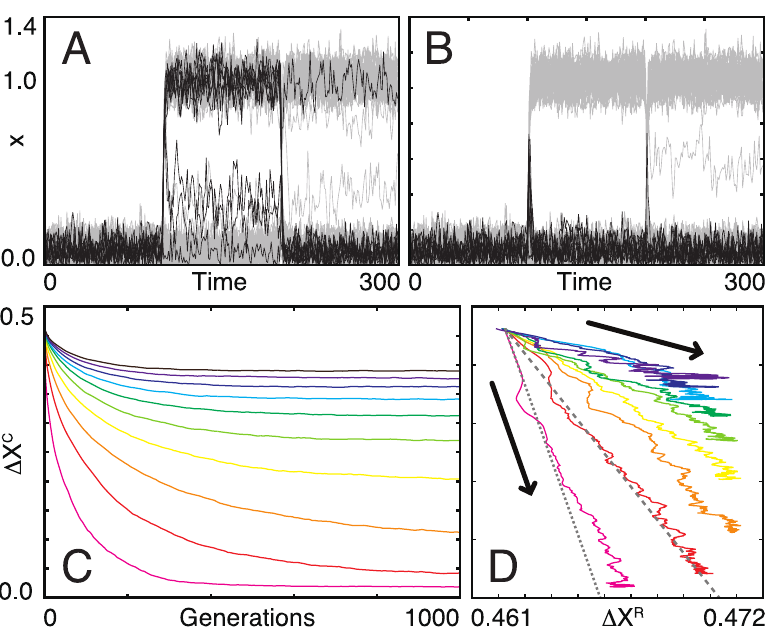
Fig 2. Evolutionary process of gene regulatory networks. (A, B) Adaptation dynamics of genes ( x i ( t )) of an individual with the highest fitness before (A: 0th generation) and after (B: 1000th generation) evolution. α was changed from 0 to 1 and from 1 to -1 at time 100 and 200, respectively. Black and gray lines indicate the time course of the core ( N C = 10) and regulator ( N R = 90) genes, respectively. (C) Changes in Δ X C from the 0th to 1000th generations and (D) the corresponding trajectory at the Δ X R – Δ X C plane. All of the trajectories start from the same point ( Δ X C = Δ X R = Δ X 0 ’ 0.462). Different color lines indicate evolutionary trajectories with different N C / N : magenta for 0.1, red for 0.2, orange for 0.3, yellow for 0.4, lime for 0.5, green for 0.6, cyan for 0.7, blue for 0.8, purple for 0.9, and brown for 1.0. Gray dotted and dashed lines are given by Eq 5 for N C = 10 10 and 20, respectively.